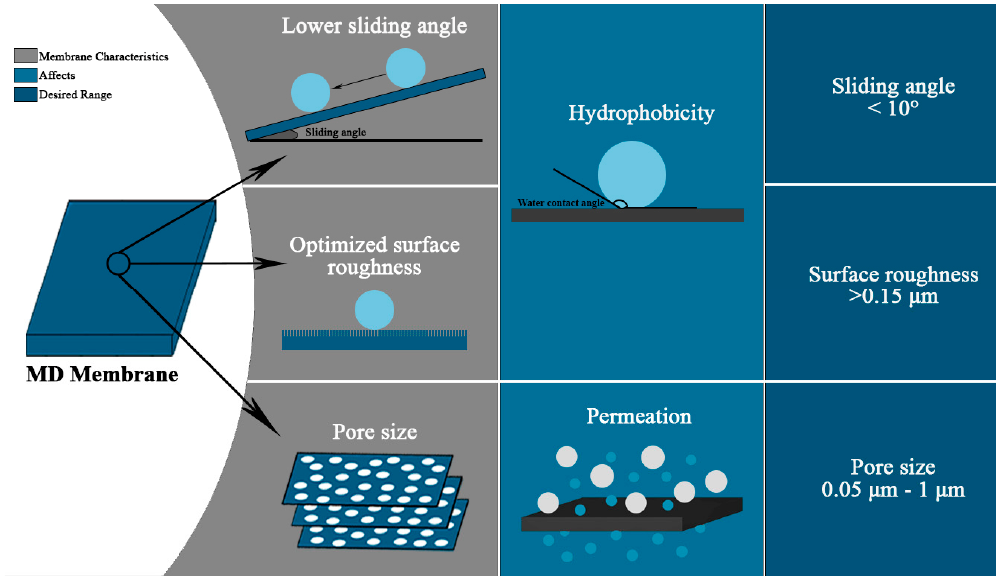
Figure 4. Basic membrane characteristics and their corresponding impacts that affect MD performance.